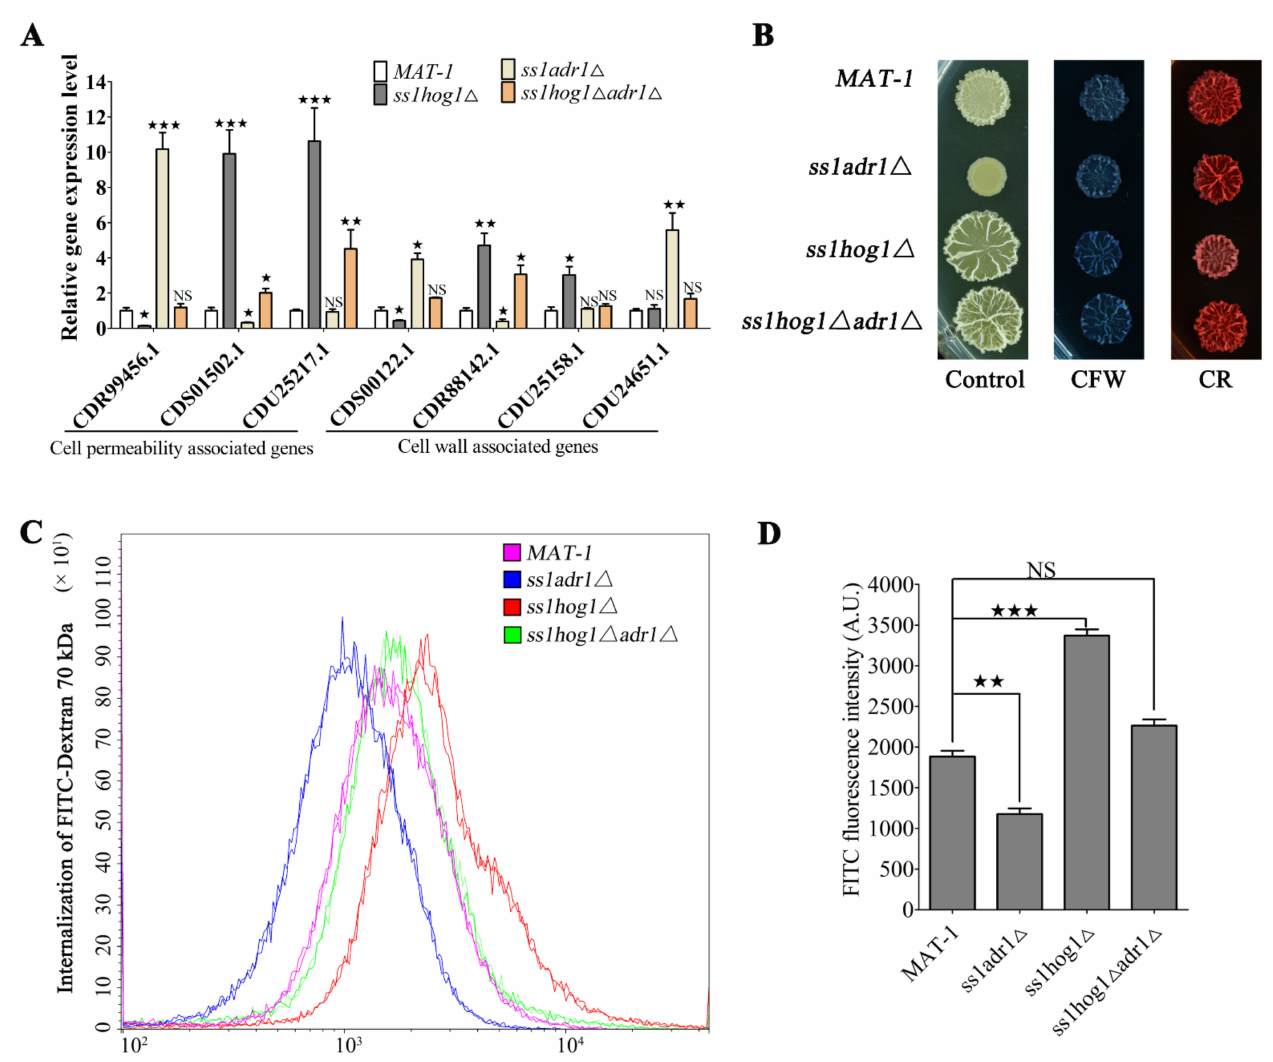
Figure 6. Effects of SsHog1 and SsAdr1 on morphology cell wall integrity and permeability. ( A ) Tran- scriptional profile of cell wall integrity- and permeability-related genes in the MAT-1 , ss1adr1 ∆ , ss1hog1 ∆ , and ss1hog1 ∆ adr1 ∆ strains. Total RNA was extracted from the haploid sporidia